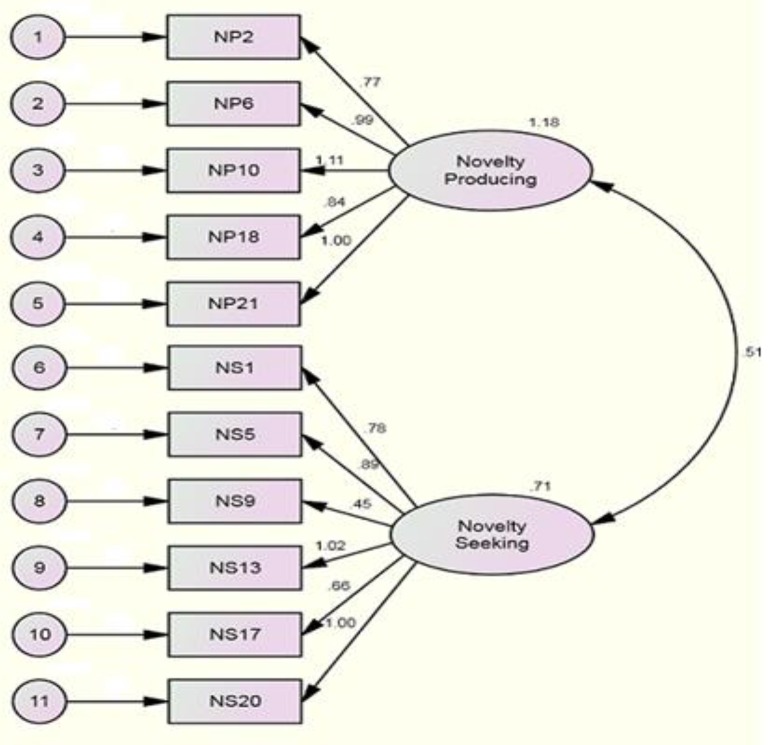
The Two factor path diagram for Model 1.